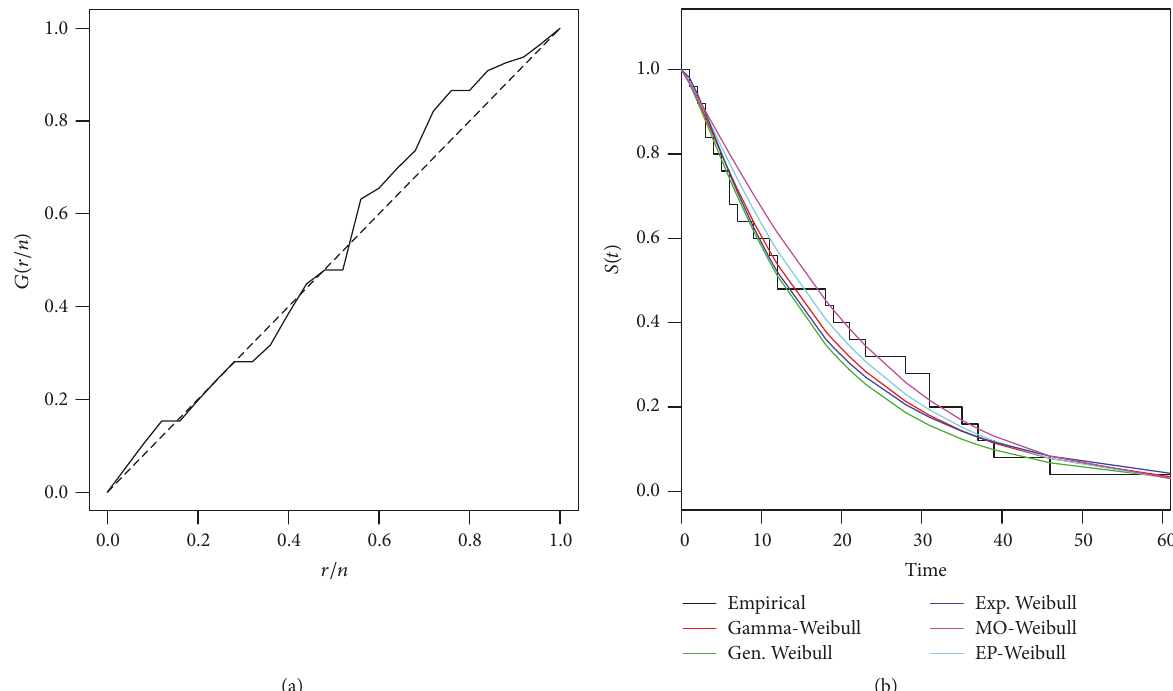
Figure 5: Transmission B empirical (a) TTT-plot, and (b) contains the fitted survival superimposed to the empirical survival function and the hazard function adjusted by distribution.